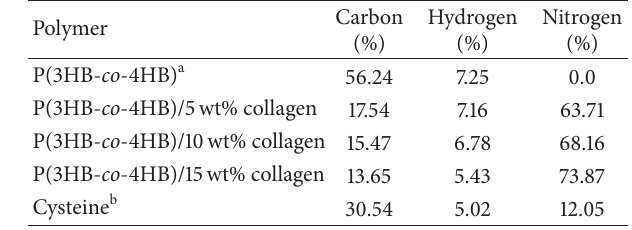
Table 2: CHN analysis of P(3HB- co -50mol% 4HB)/collagen